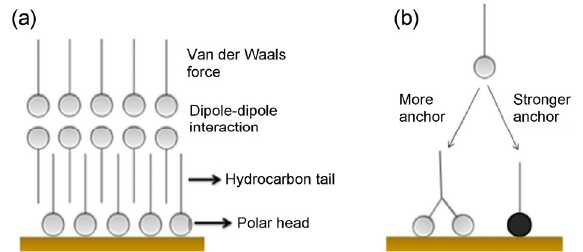
surface. (b) Designing novel